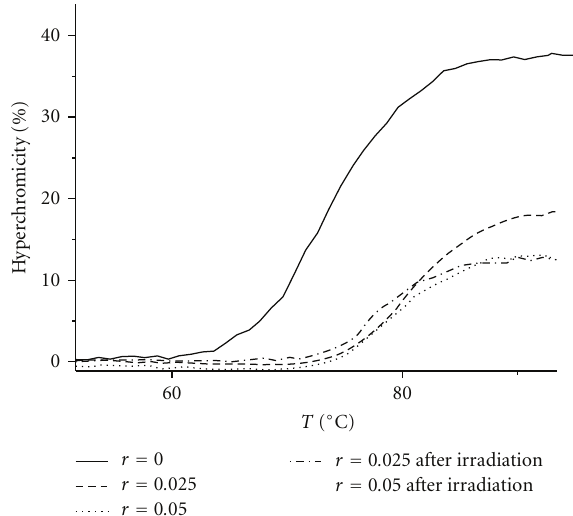
Figure 3: Thermal denaturation curves of C.T.-DNA in the presence of the complex ReOCl 3 pq before and after irradiation at increasing molar ratios r , pH = 7.0.